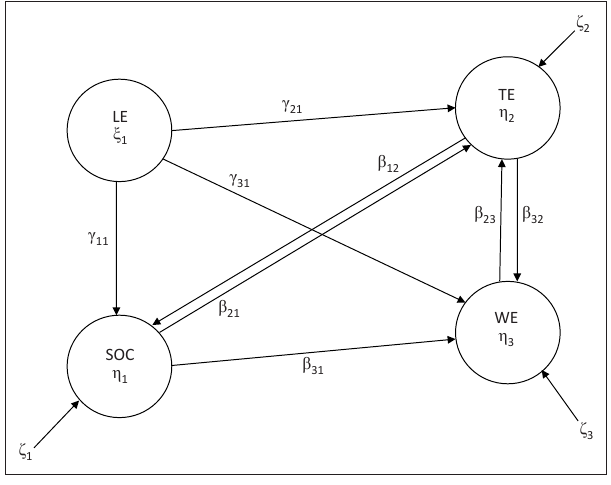
FIGURE 2: Proposed work engagement structural